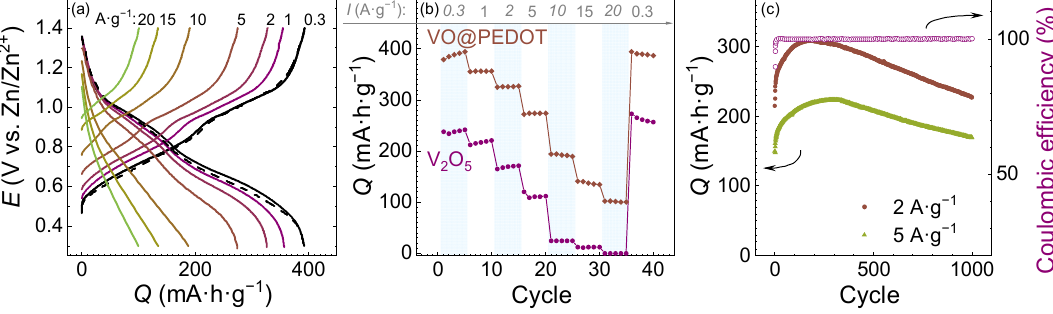
Figure 5. ( a ) GCD curves for VO@PEDOT at current densities from 0.3 A ∙ g − 1 to 20 A ∙ g − 1 (dashed line is at 0.3 A ∙ g − 1 after all other currents); ( b ) C-rate performance of VO@PEDOT with comparison to initial V 2 O 5 electrodes (after 10 cycles of activation); ( c ) GCD cycling performance of VO@PEDOT at 2 A ∙ g − 1 and 5 A ∙ g − 1 .